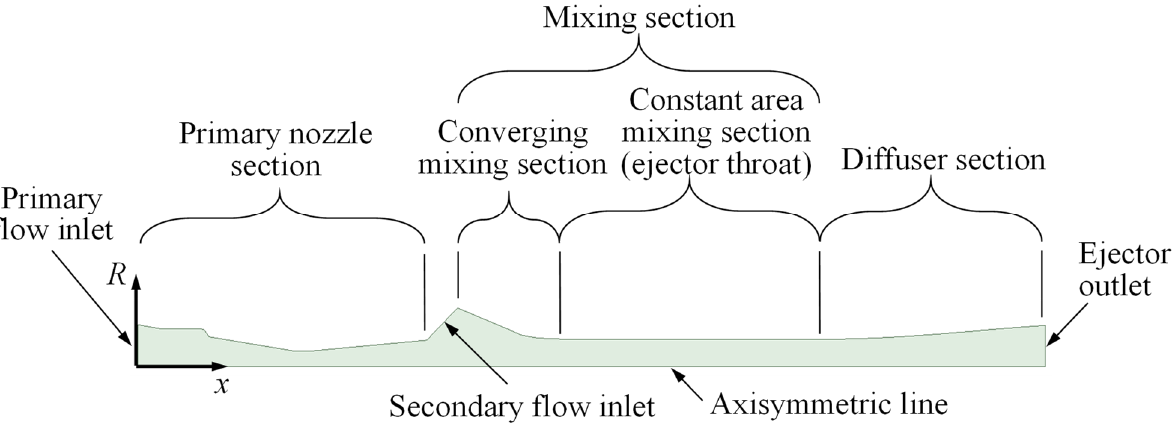
Figure 3. The internal contour of Al-Ansary’s ejector [9] (ejector G1) used for the computational fluid dynamics (CFD) validation in the current study.